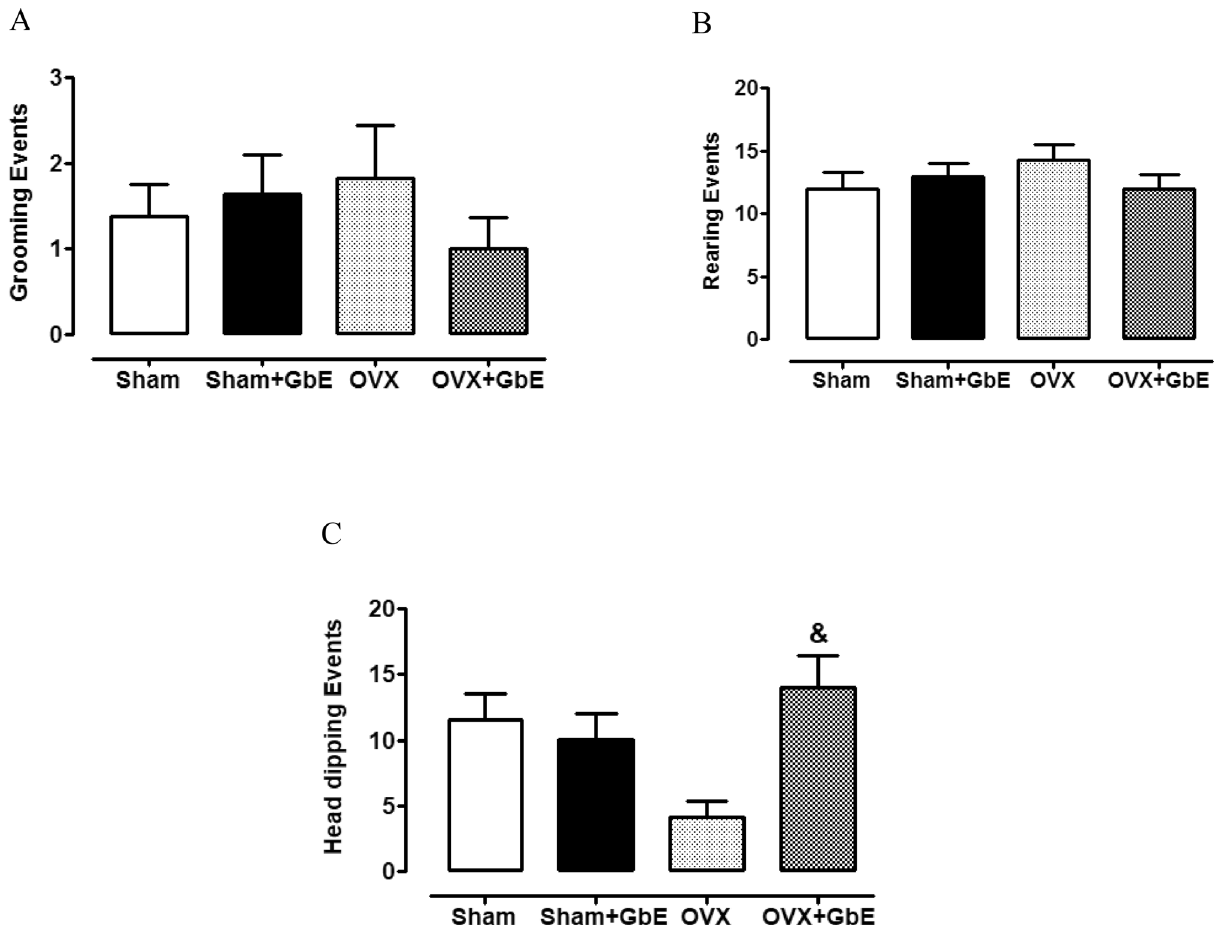
Figure 2. Anxious-like behaviours during the EPM test. Number of events of ( A ) grooming, ( B ) rearing and ( C ) head dipping during the EPM test of Sham (n = 8–9), Sham + GbE (n = 10–11), OVX (n = 10–11) and OVX + GbE rats (n = 9–11). & p ≤ 0.05 vs.